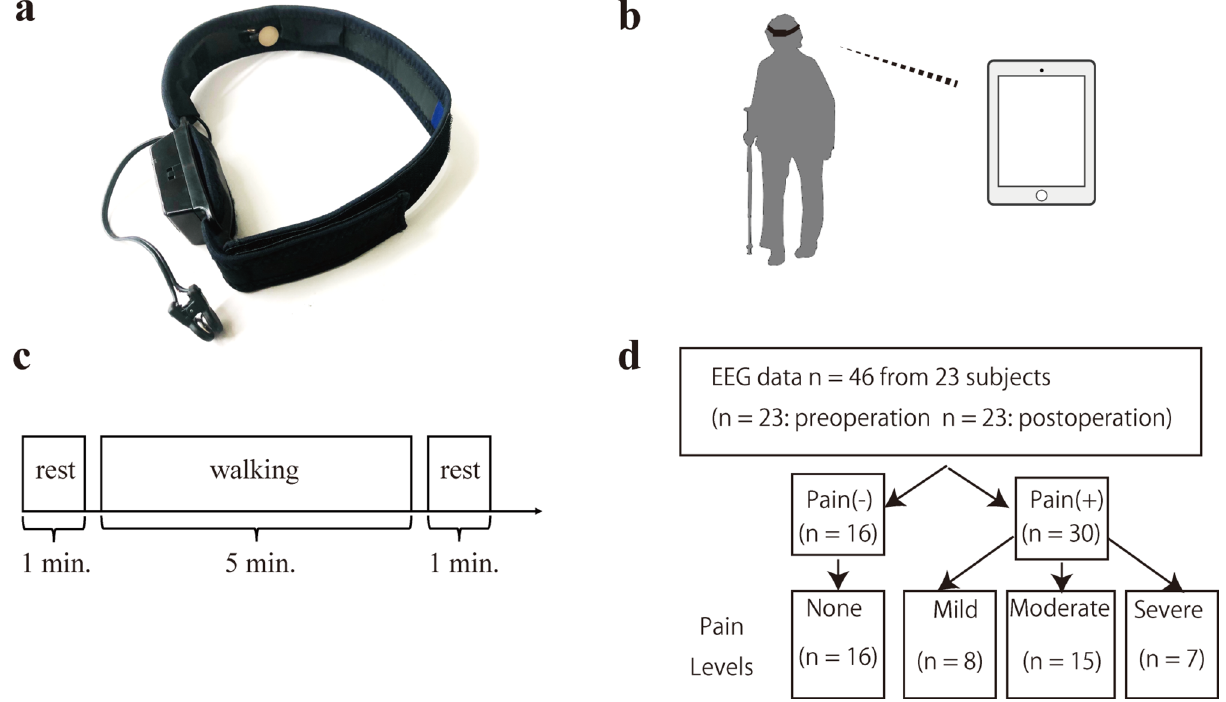
Figure 1. Development of an EEG recording system applicable to walking. ( a ) The wearable EEG recording device, MindWave Mobile II (Neurosky), used in this study to record the EEG from electrode position Fp1. Conductive material reference and ground electrodes were contained within the ear clip. ( b )Wireless control of the device with an iPad. Subjects were able to walk with hands free. ( c ) Task diagram. The task consisted of a one-minute rest block with subjects in a sitting position with eyes closed, then a walking block of 5 min, and finally a rest block like the first. For the walking block, we encouraged patients to walk at a uniform pace and in a way that simulated their daily habits. ( d ) Pain classification flowchart. We asked about hip pain while recording EEG, before and after THA surgery. We collected 46 sets of NRS data from 23 subjects, and sets were subdivided into Pain (–) (NRS 0, n = 16) or Pain ( +) (NRS ≥ 1, n = 30) groups. Pain ( +) groups were subdivided into quartiles, as indicated. Each EEG data recording session of 300 s from 46 individuals was divided into 10 data sets of 30 s. Thus the total number of datasets analyzed was